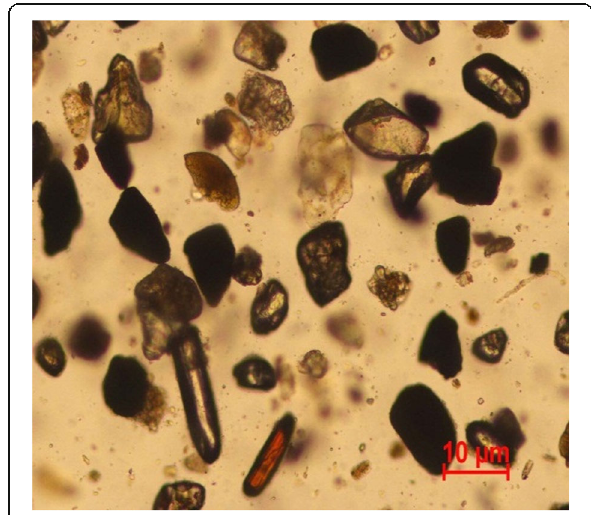
Fig. 11 Heavy fraction composed of opaque ’ s (black), zircon (zoned colorless euhedral to subhedral grains), staurolite (reddish brown at the lower part), and epidote (pale green angular grains at the upper left corner), heavy fraction, PPL. × 100